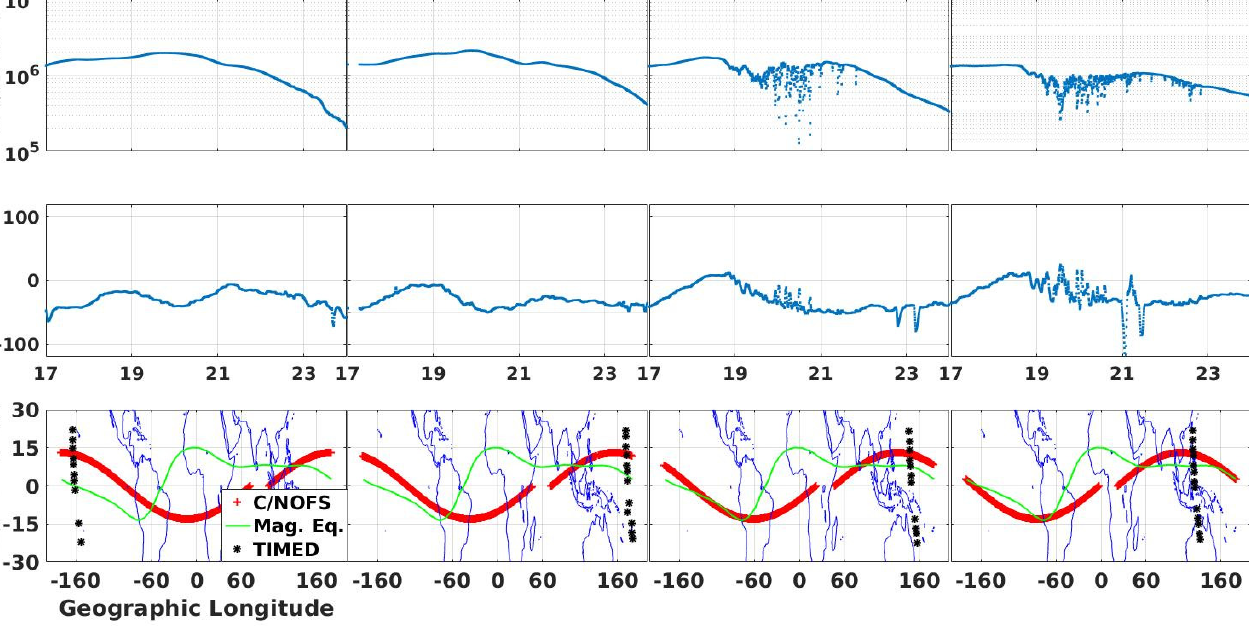
Figure 3. Ion density ( top row , 1st and 2nd columns represent non-irregular ionosphere whereas 3rd and 4th columns represent irregular ionosphere ) and plasma vertical drift velocity ( middle row , positive and negative values represent upward and downward, respectively) from C/NOFS and coordinates of data from C/NOFS and SABER satellites ( bottom row ) versus LT on 14 October 2011.